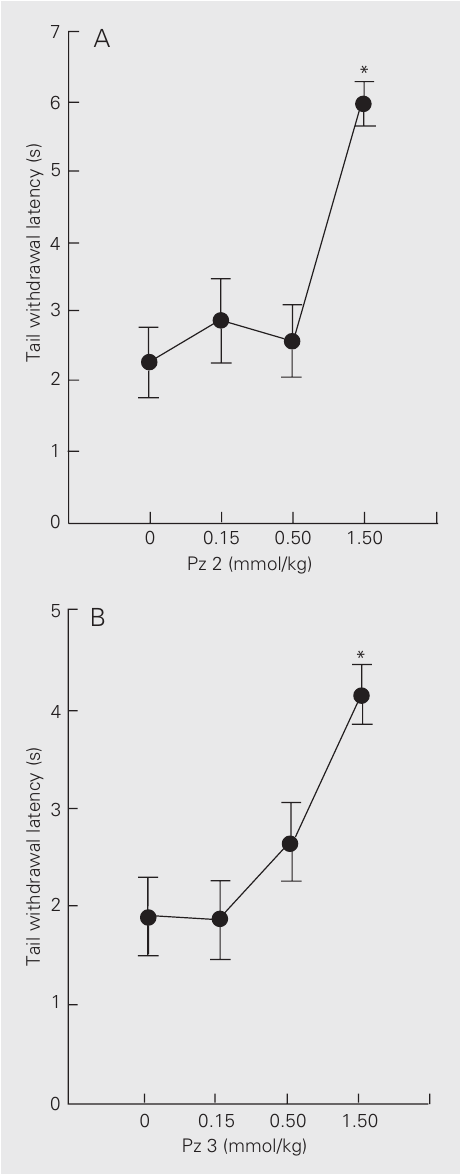
Figure 1. Dose-response curve for Pz 2 (A) and Pz 3 (B) acting on the latency of mouse tail withdrawal from a hot water bath (55 o C). Data are reported as mean ± SEM for N = 6 ani- mals per group. *P < 0.05 com- pared with vehicle group (Stu- dent-Newman-Keuls